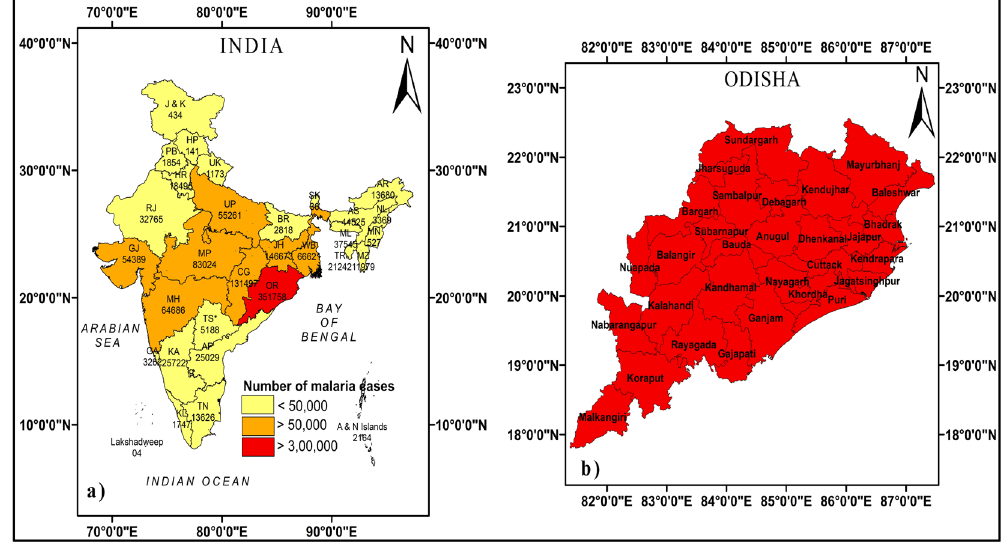
Figure 1. Study Area. ( a ) State wise number of malaria cases in India during 2007–2017, highlighting the study area (Odisha), ( b ) names of districts in